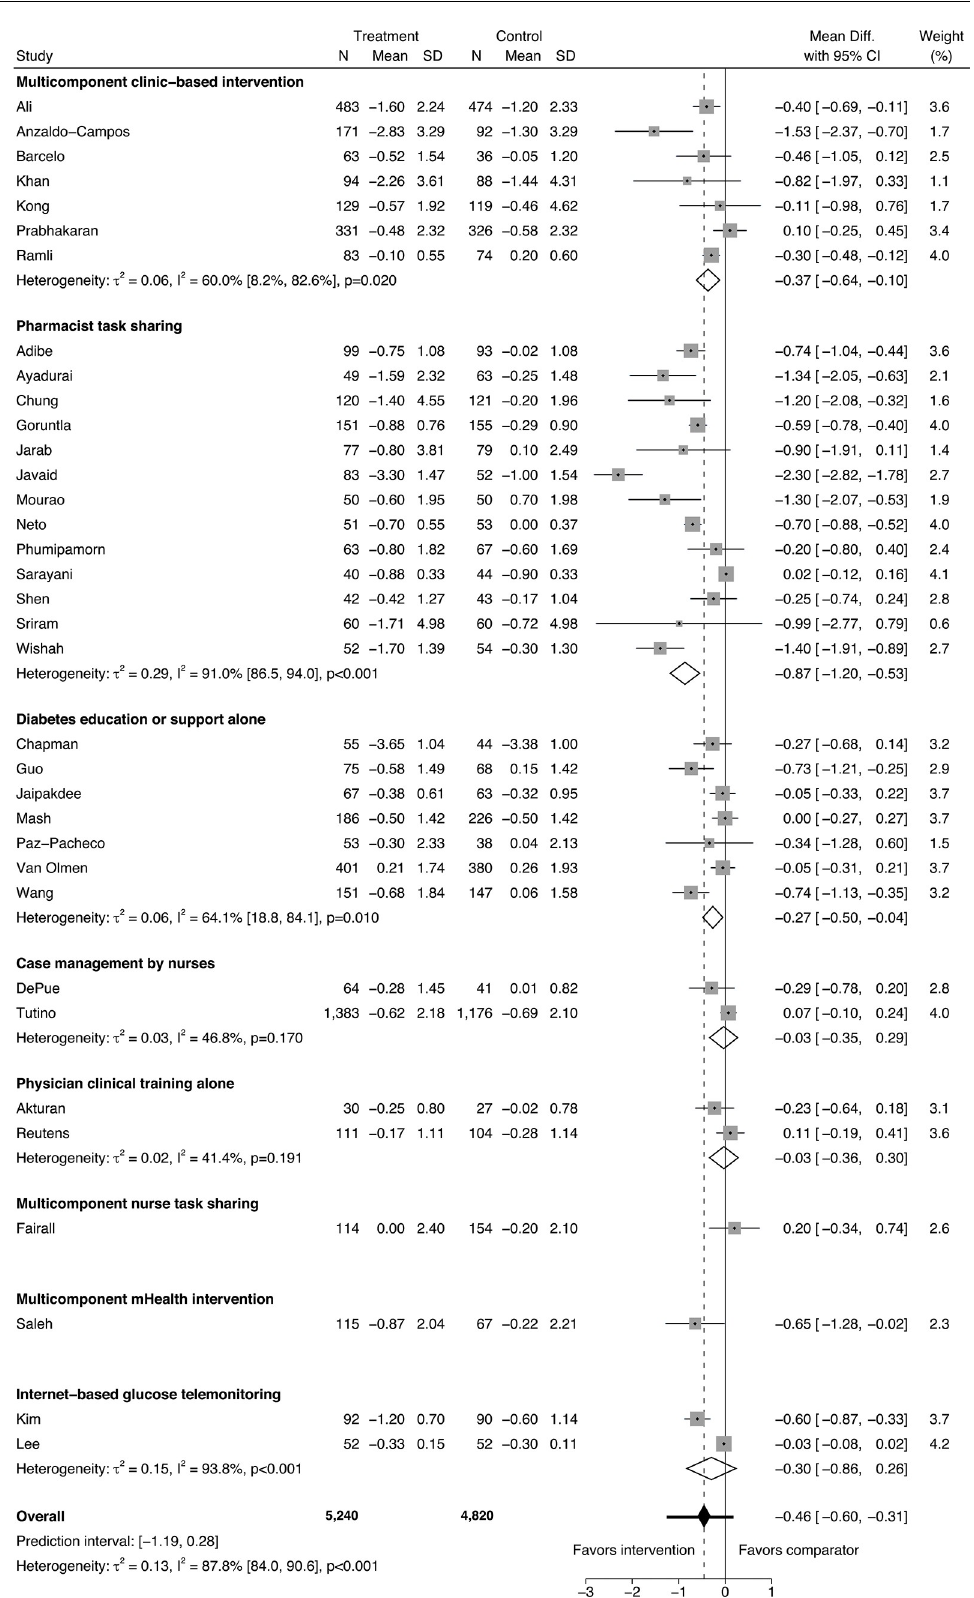
PLOS Medicine| https://doi.org/10.1371/journal.pmed.1003434 November12,